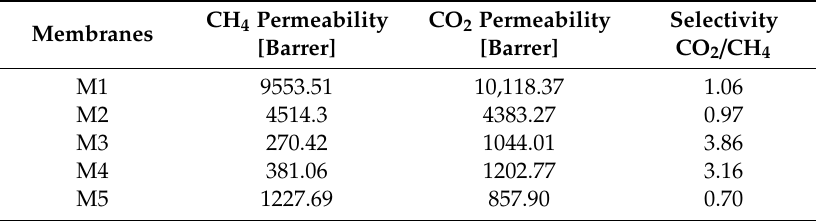
Table 4. Gas permeability and selectivity of PPSU based membranes measured at 2 bar and 25 ◦ C, excepting M1 membrane measured at 0.2 bar at 25 ◦